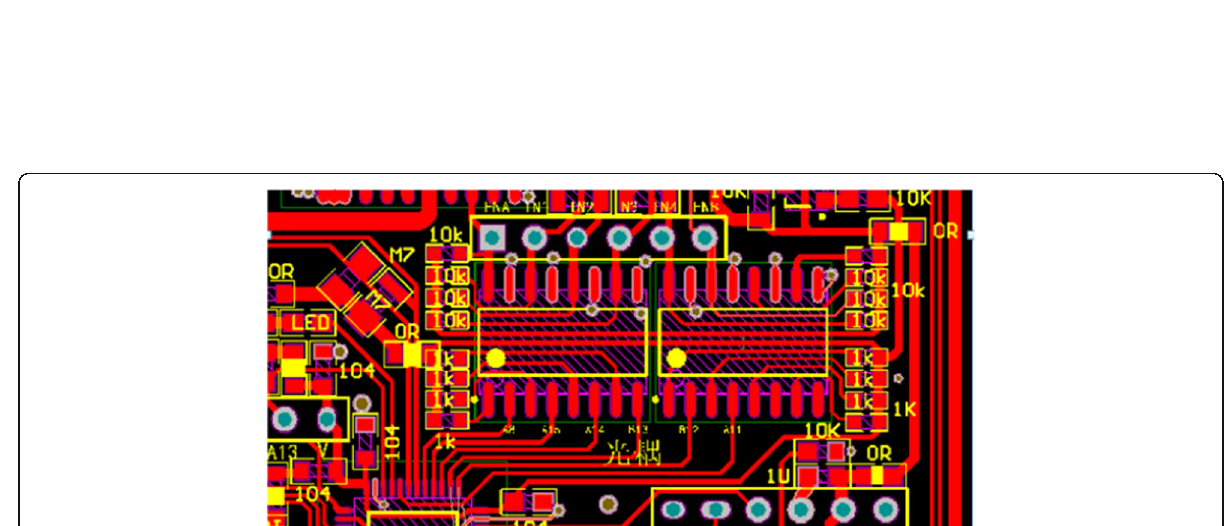
Fig. 30 Photoelectric isolation circuit for the motor drive